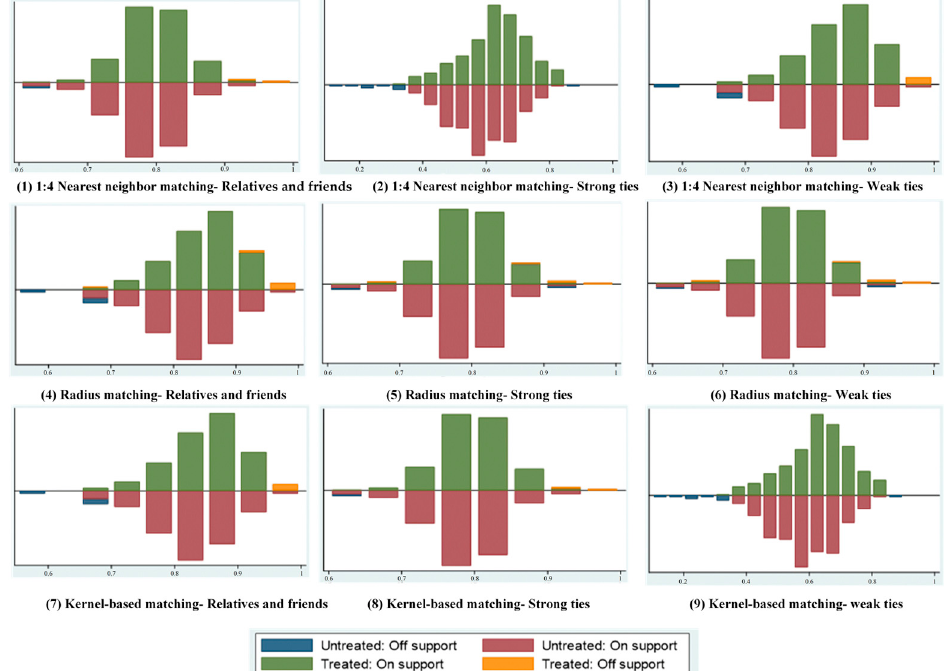
Figure 3. Influence of cohort effect after bias